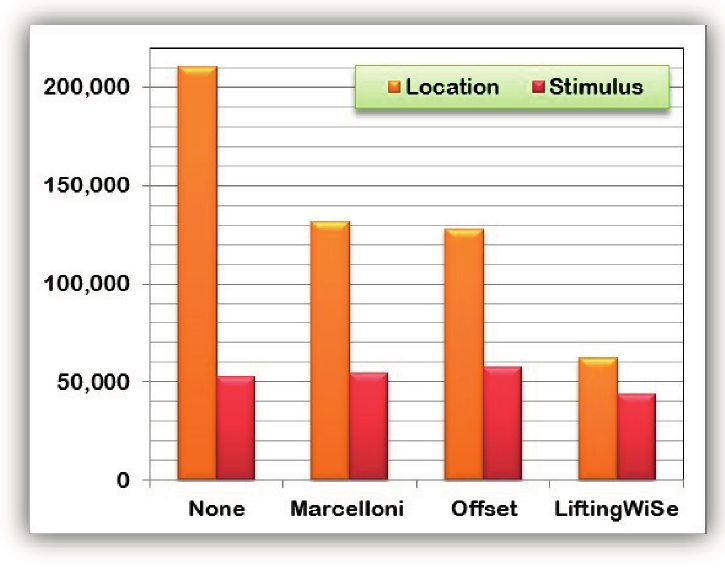
Figure 8. Disseminated bits through 1200 randomly deployed nodes.